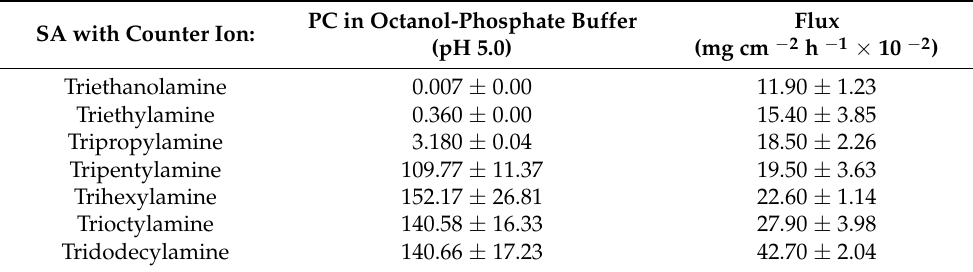
Table 4. Effect of tertiary amines on the PC and the flux of SA through human epidermis. Donor phase comprised equimolar concentrations of salicylate anion and amine counter ion, with actual concentration of SA not provided by the authors; donor solvent: ethanol to propylene glycol (2:1 v / v ) ( n ≥ 3, values represent the mean ± S.E.M.) Adapted from [31], Wiley, 2000. SA with Counter Ion: